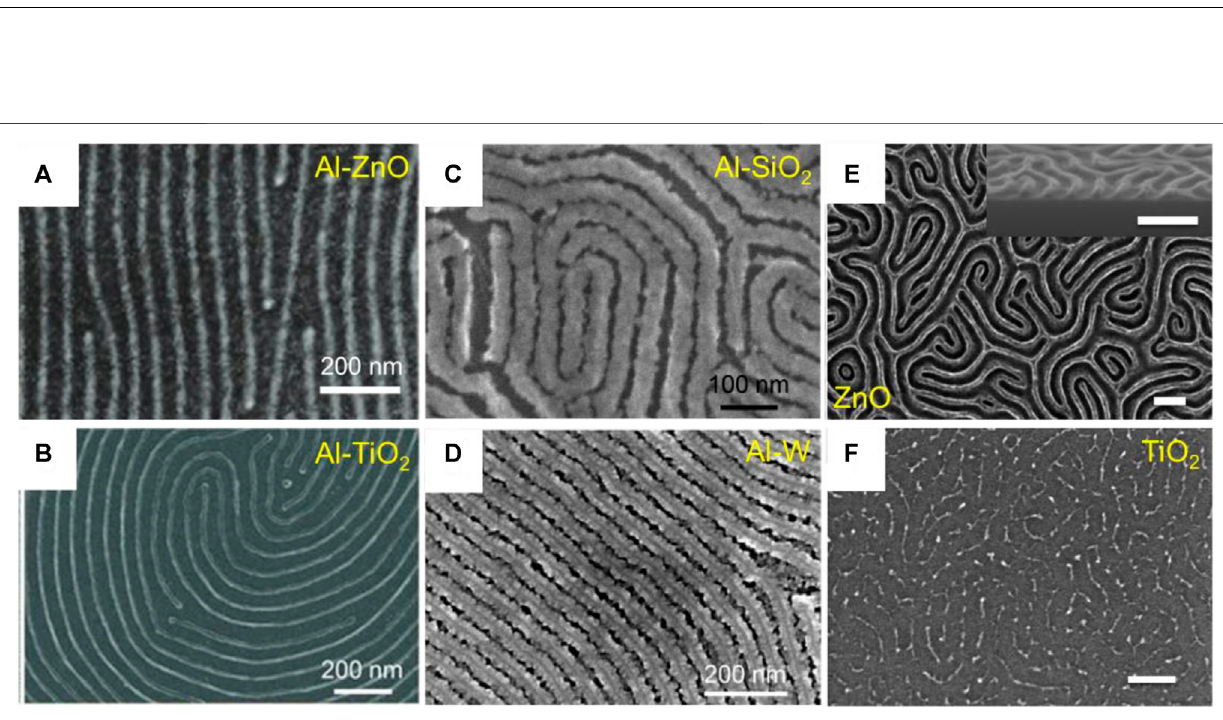
Frontiers in Nanotechnology |